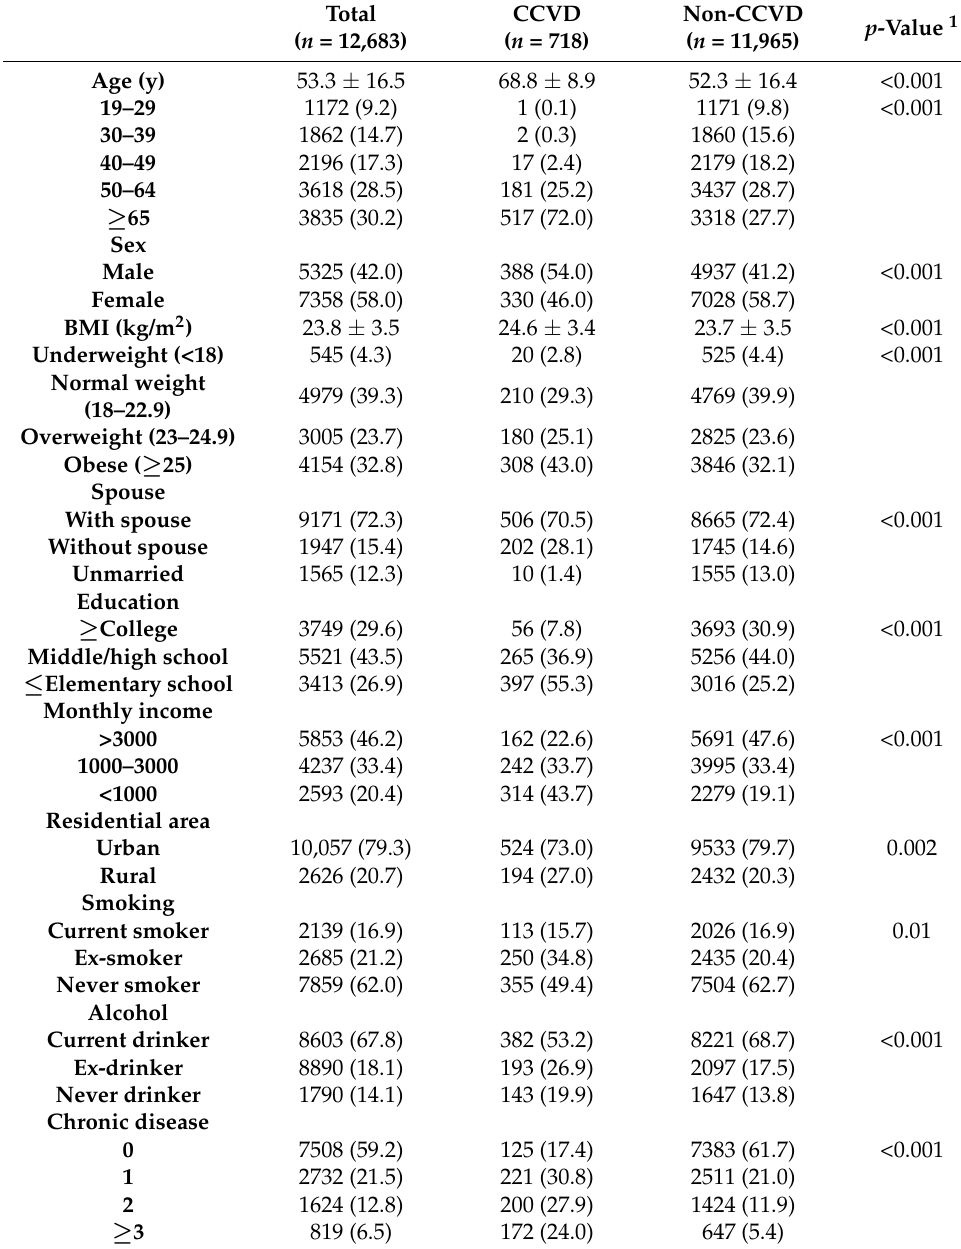
Table 1. General characteristics of study